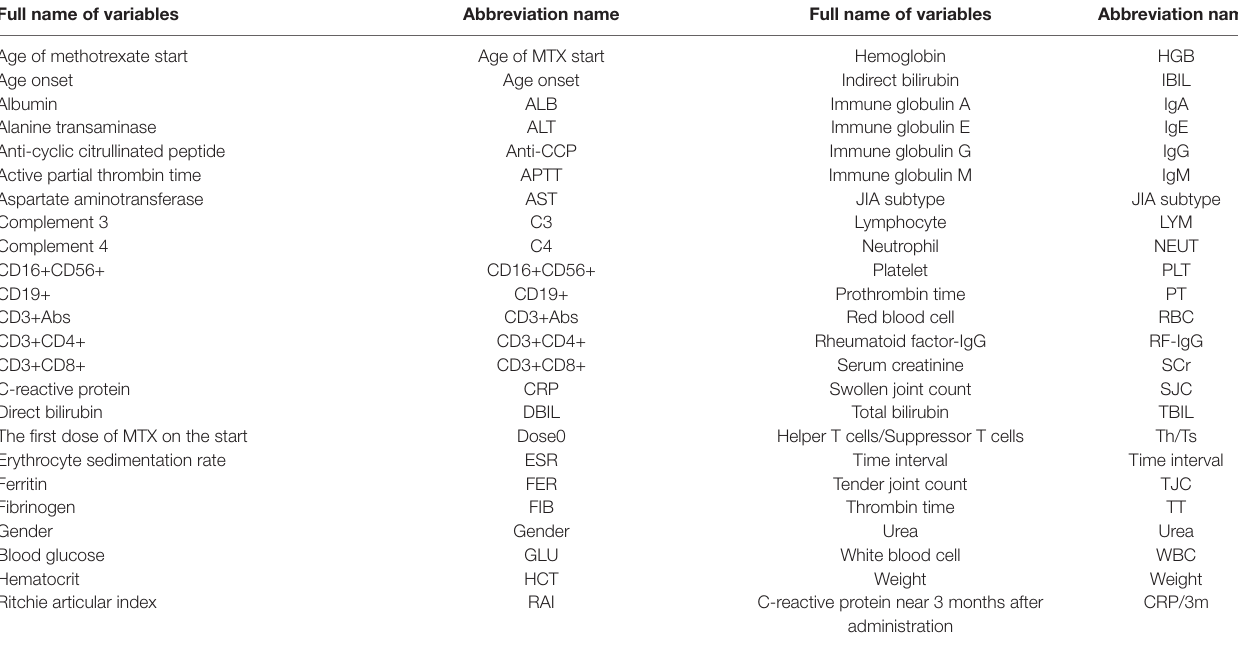
TABLE 1 | The full name and abbreviation name of